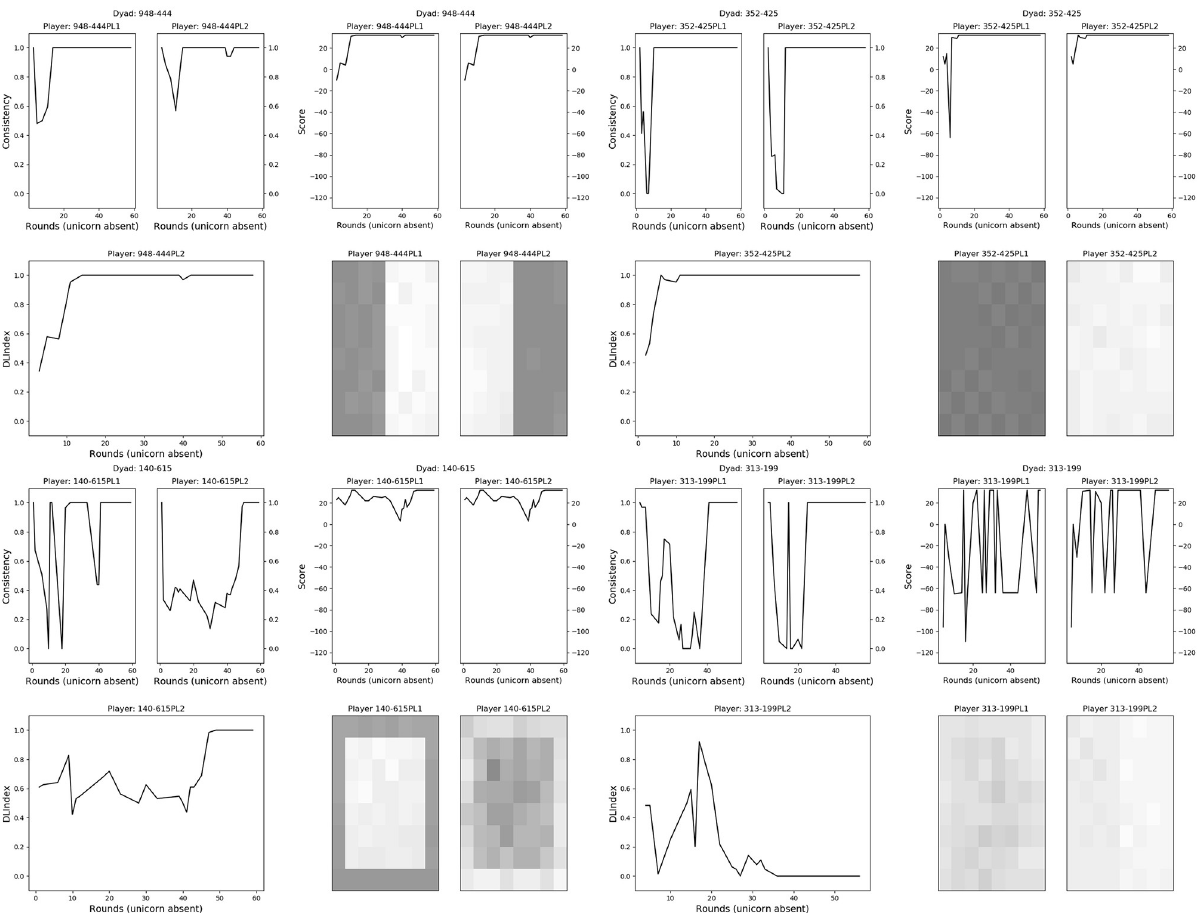
Fig 2. Examples of observed behaviors. Each quadrant contains four (sets of) panels displaying the dynamics through 60 rounds of gameplay for a dyad. The dynamics is measured by means of consistency (top left, within each quadrant), score (top right), and magnitude-coded tiles—i.e., how often a particular tile was selected—from each player (bottom right), as well as the dyad’s DL INDEX (bottom left). Only rounds on which the unicorn was absent were considered. The top-left quadrant presents a dyad that relatively quickly converged on a LEFT - RIGHT split. The top-right quadrant presents another quickly convergent dyad, but this time on an ALL - NOTHING split. The bottom-left quadrant shows a slowly convergent dyad that negotiated an INSIDE - OUTSIDE split, and the bottom-right quadrant shows a dyad with unsuccessful division of